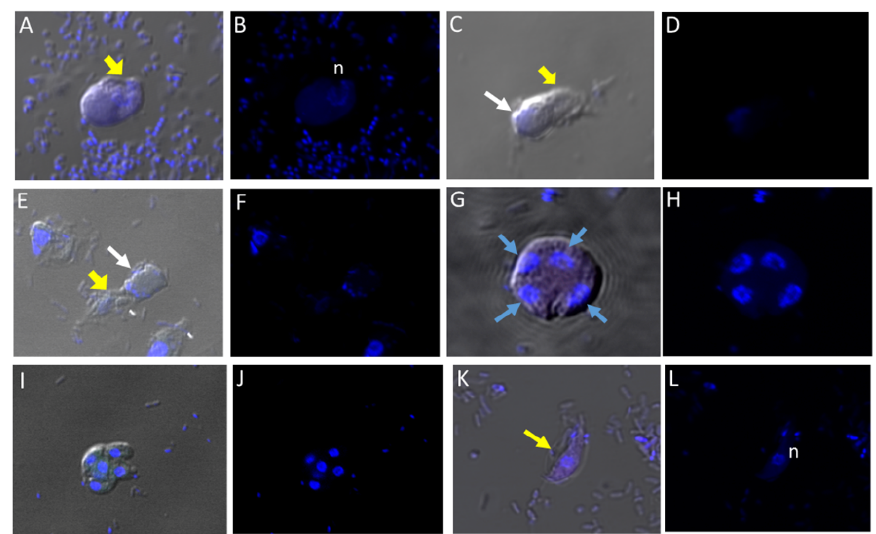
Figure 5. ( A – L ): Differential Interference contrast (DIC) microscopy of DAPI stained Colpodella sp. (ATCC 50594) life cycle stage transitions. DIC and DAPI staining of pre-cyst and cyst stages of Colpodella sp. (ATCC 50594). Yellow arrowhead shows frayed anterior end of encysting trophozoites in panels ( A , C , E ). White arrows identify the DAPI stained aspirated contents from the prey in the posterior food vacuole. A four-nuclei cyst is identified in panels ( G ) and ( H ), a five-nuclei cyst in panels ( I ) and ( J ) and a young trophozoite in panels ( K ) and ( L ). The central nucleus (n) was identified.